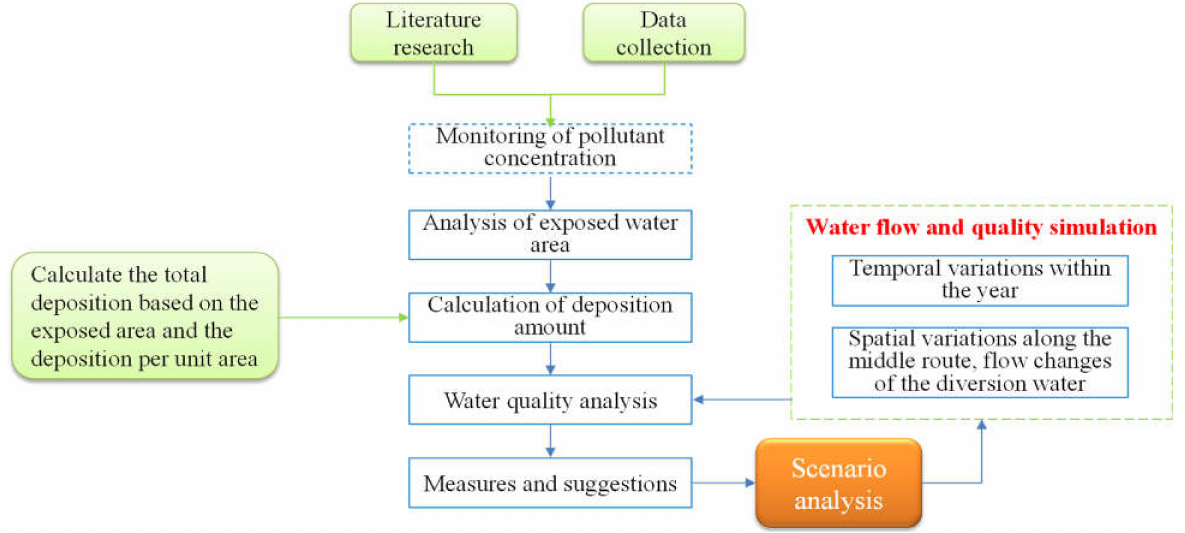
Figure 3. Implementation process of the